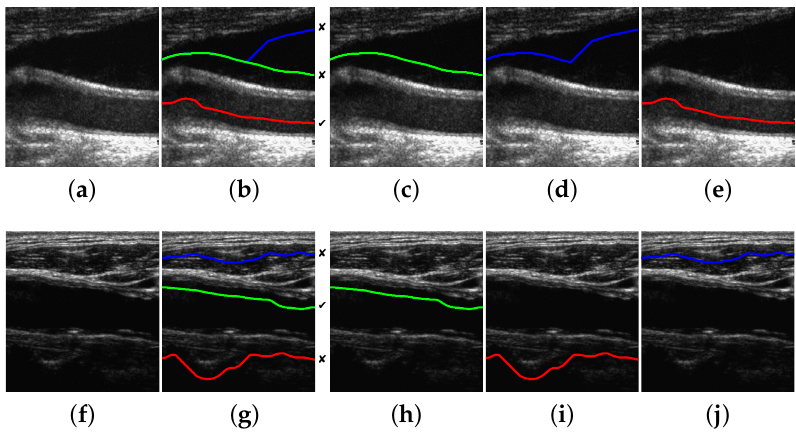
Figure 13. Examples of misdetections for the proposed method. From left to right: ( a , f ) input image; ( b , g ) detected candidates indicating which one is the correct lumen ( (cid:51) ); ( c , h ) symmetry-based selection; ( d , i ) intensity-based selection; and ( e , j ) contrast-based selection. The lumen centerlines selected by the Best- Sym [18] and the Bottom-most methods correspond to (c,h) and to (d,j),